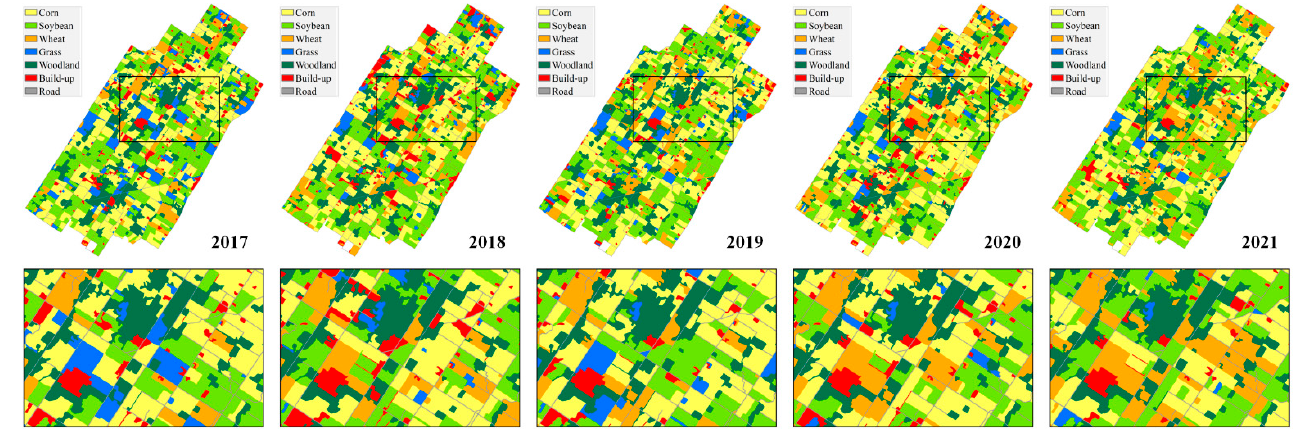
Figure 8. Annual crop mapping results from 2017 to 2021.